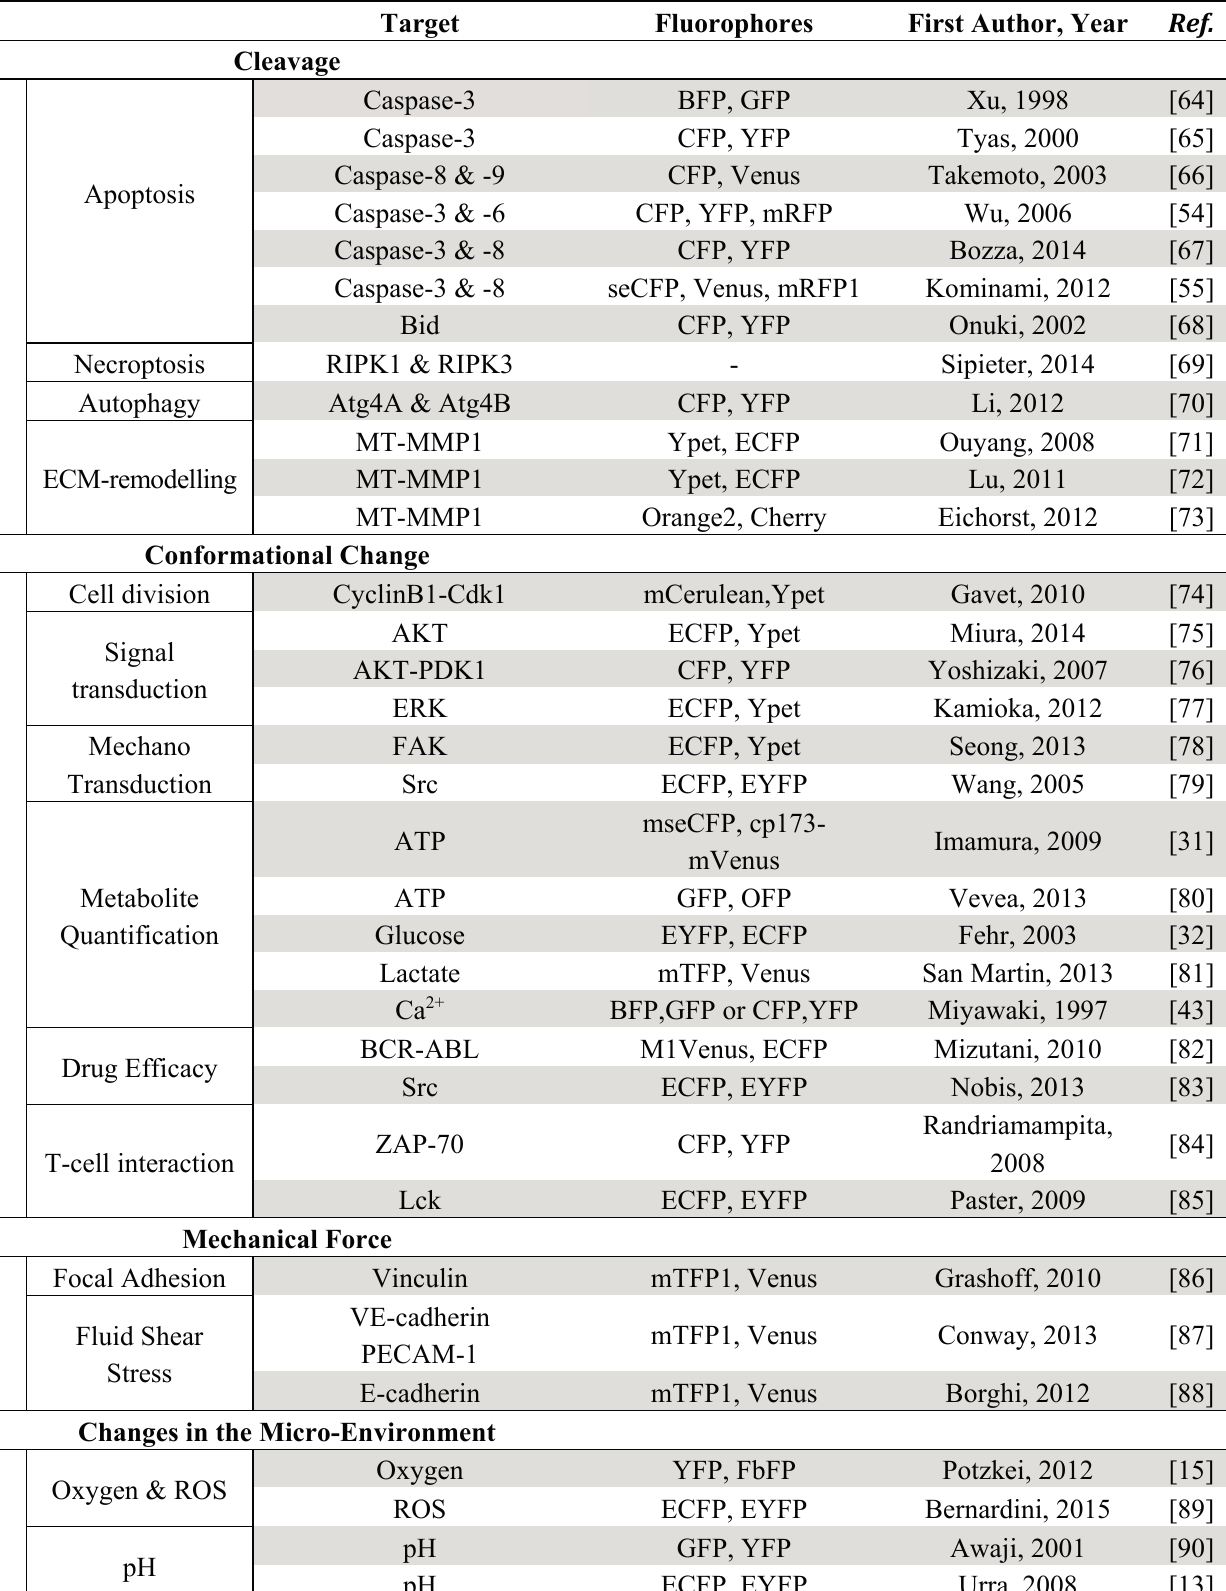
Table 2. A list of original FRET-sensors covered in this